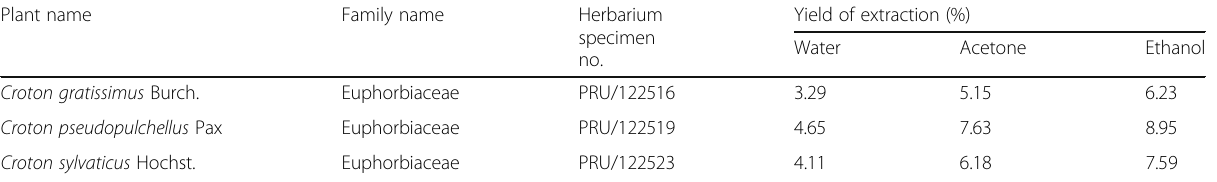
Table 1 Herbarium specimen identification and yield of crude extracts from the three Croton